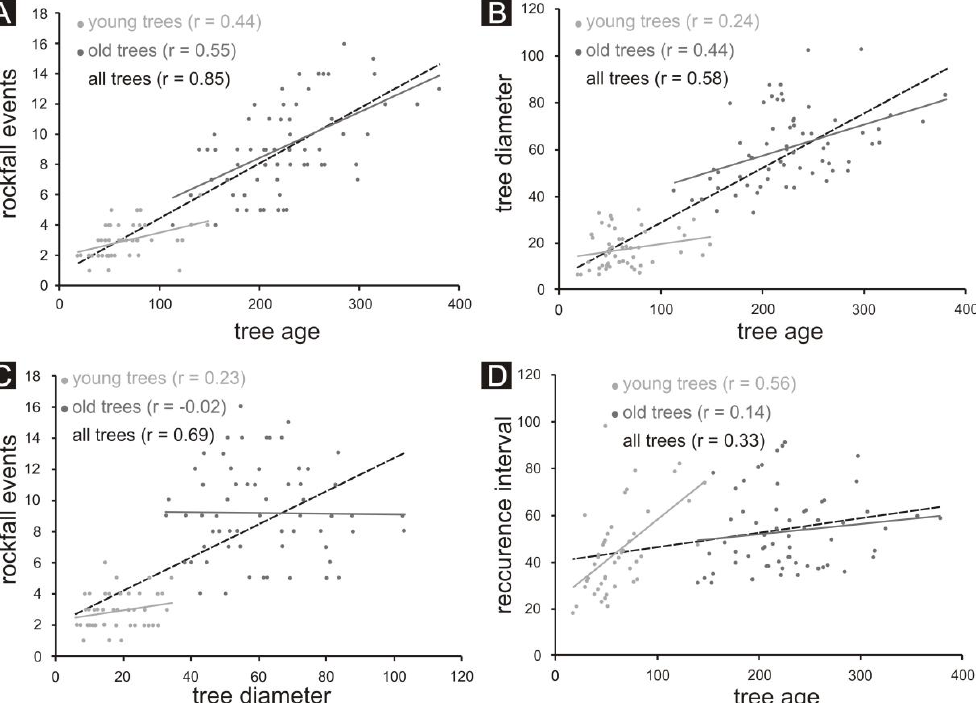
Fig. 7. Graphical relationships between selected parameters of trees and indicators of rockfall activity. 569